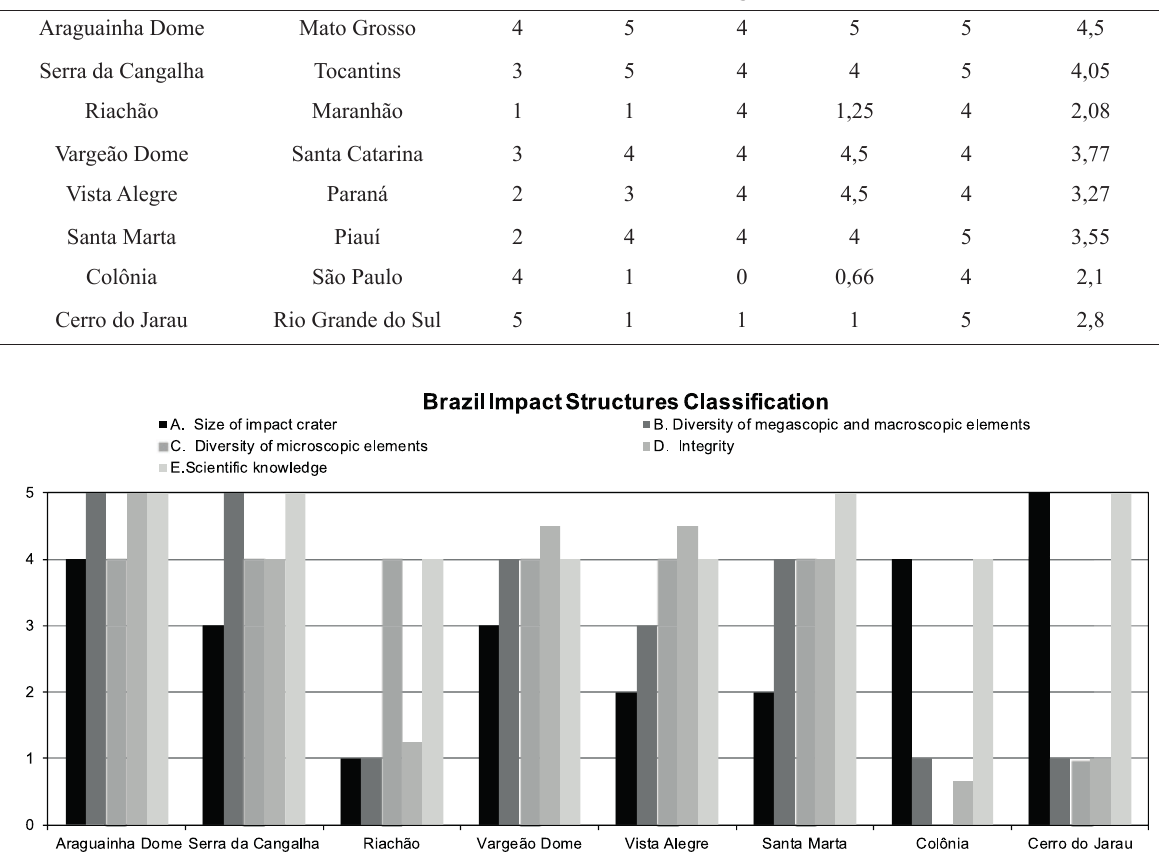
Figure 2 - Graphical representation of the results of the fi ve criteria assessment for Brazilian impact structures.